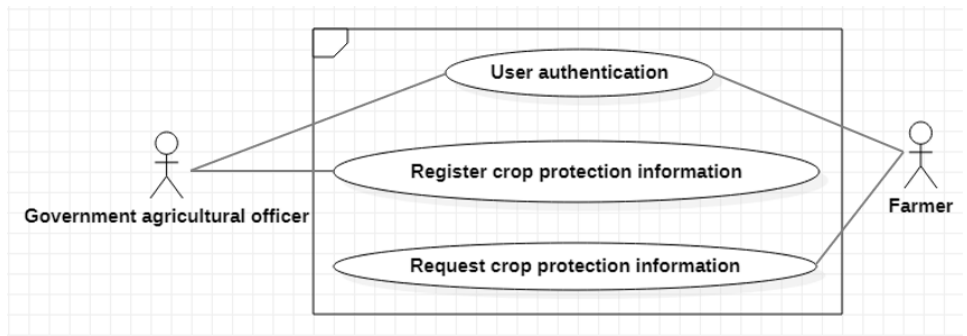
Figure 1. Use case diagram showing user